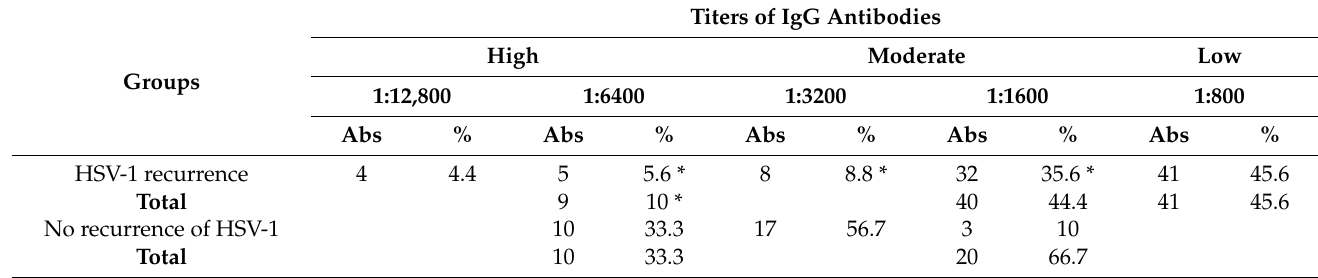
Table 2. Frequency of distribution (%) of IgG antibodies to HSV-1 among pregnant women in the second trimester of